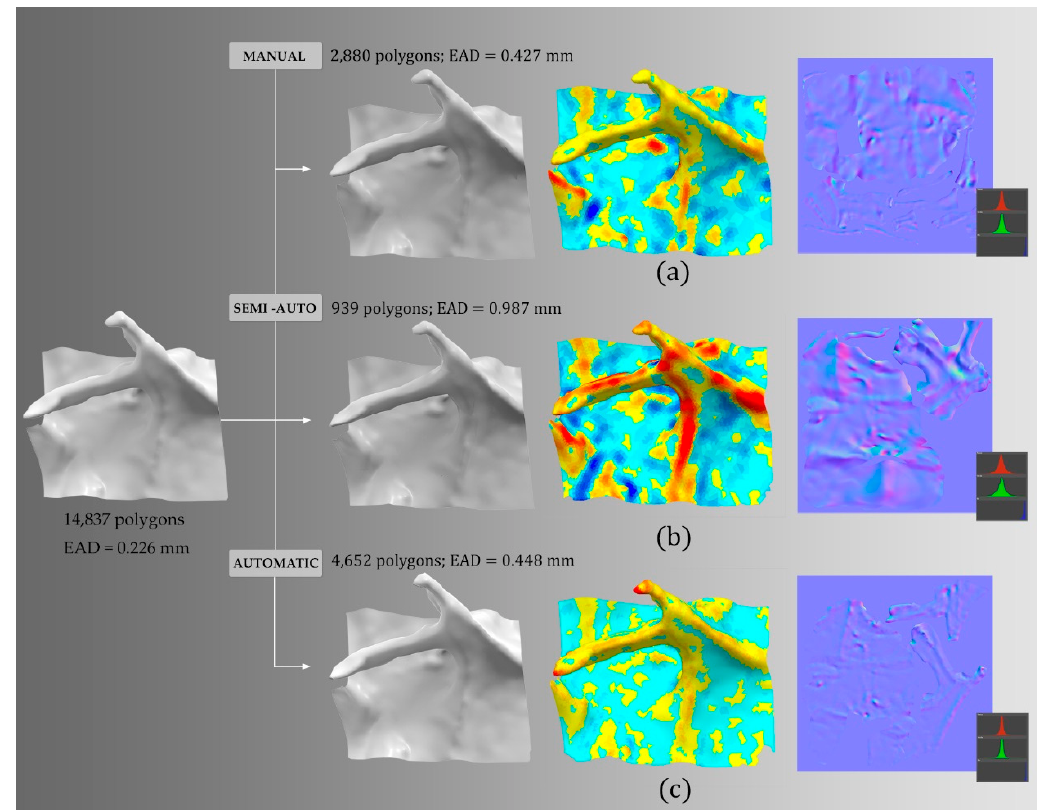
Figure 14. A high-poly and three low-poly versions with normal maps applied. Manual retopology guarantees a high visual reliability with small deviations ( a ); automatic quad-dominant remeshing with small retouches leads to lower resolutions, it increases deviation but still maintains visual reliability ( b ); automatic intermediate reduction makes the use of normal maps almost unnecessary since the blue base color prevails (R = 128; G = 128; B = 255) ( c ). A significant deviation between a master model and a low-poly corresponds to a much higher color variety with highly contrasting gradients.